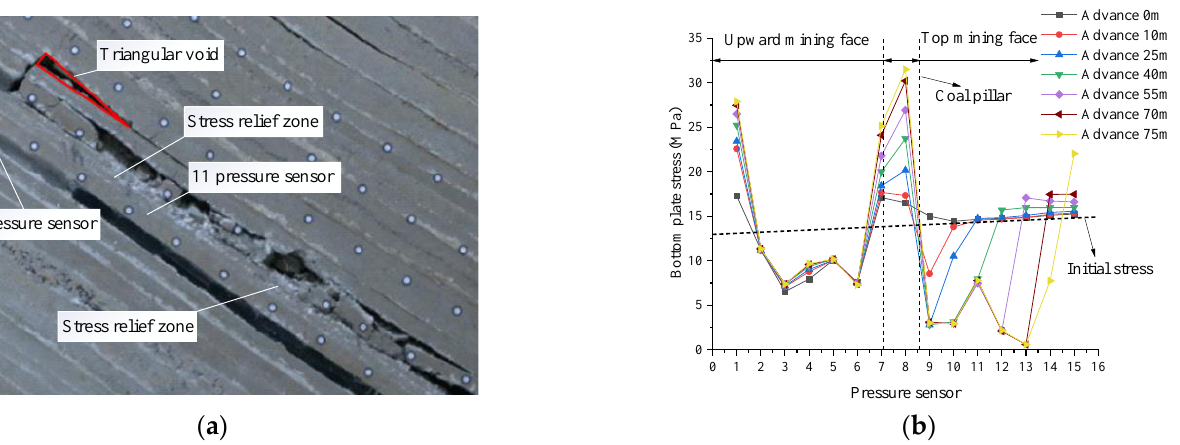
Figure 9. Stress distribution of top mining floor. ( a ) Mining 75 m in the top mining face; ( b ) stress diagram of top mining floor.